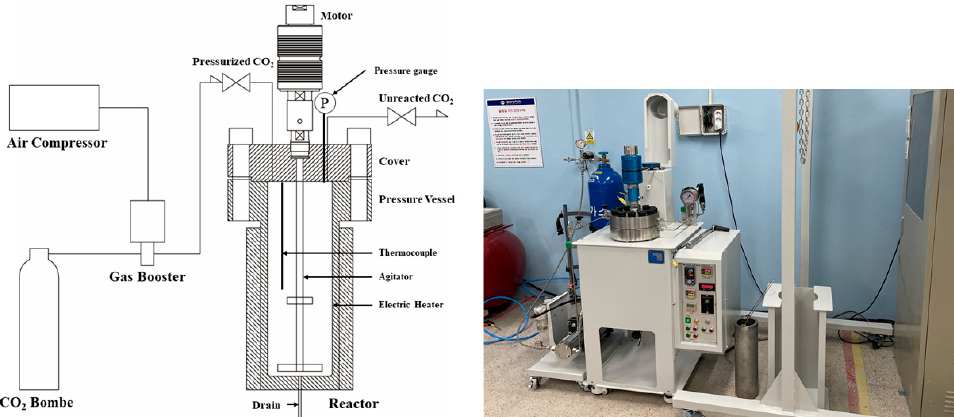
Figure 4. Schematic and photograph of the supercritical CO 2